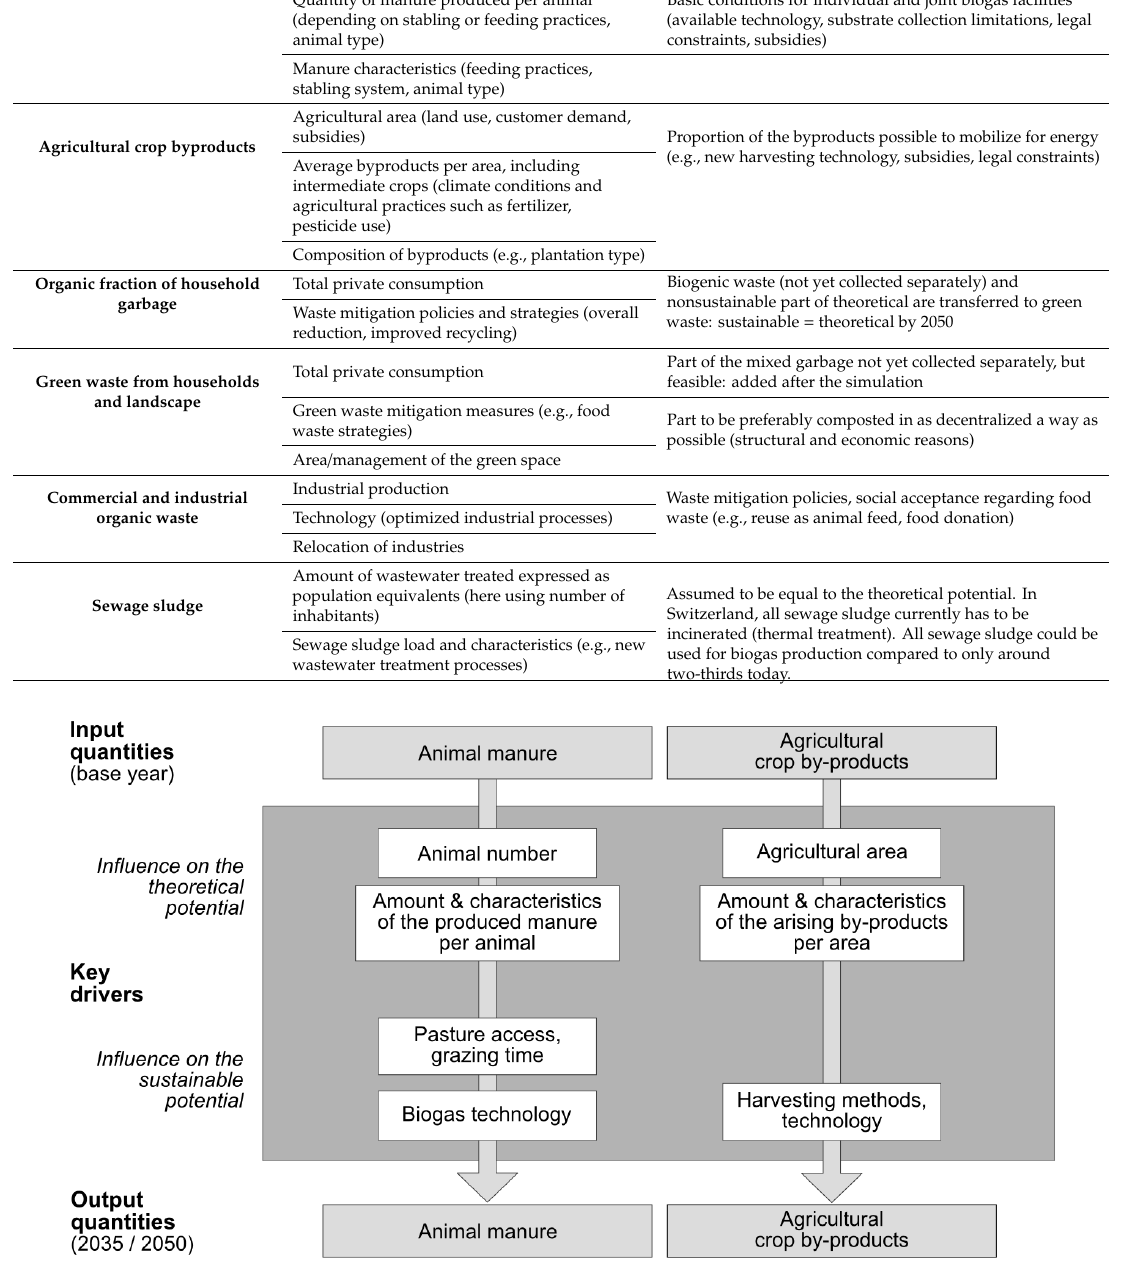
Figure 2. Key drivers for anthropogenic wastes (organic fraction of household garbage, green waste from households and landscape, commercial and industrial organic waste, and sewage sludge).